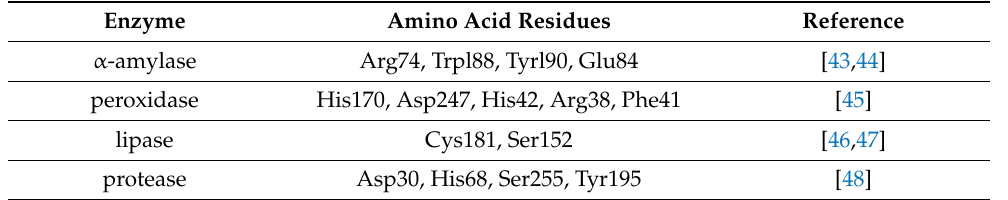
Table 2. Different amino acid residues by the enzyme. Enzyme Amino Acid Residues Reference α -amylase Arg74, Trpl88, Tyrl90, Glu84 [43,44] peroxidase His170, Asp247, His42, Arg38, Phe41 [45] lipase Cys181, Ser152 [46,47] protease Asp30, His68, Ser255, Tyr195